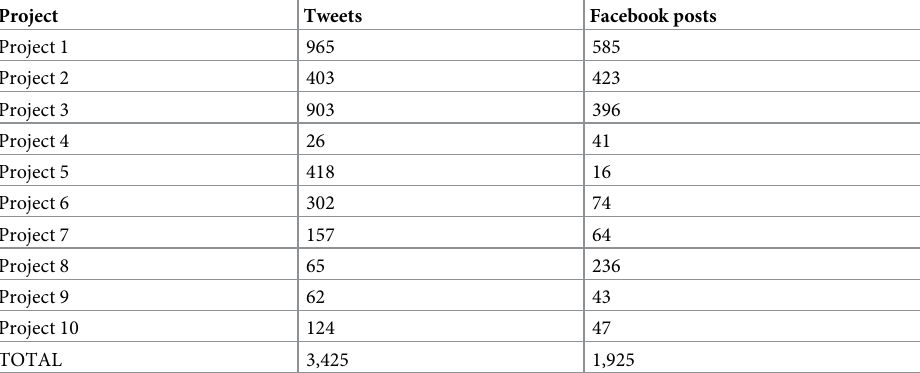
Table 6. Summary of the Twitter and Facebook data